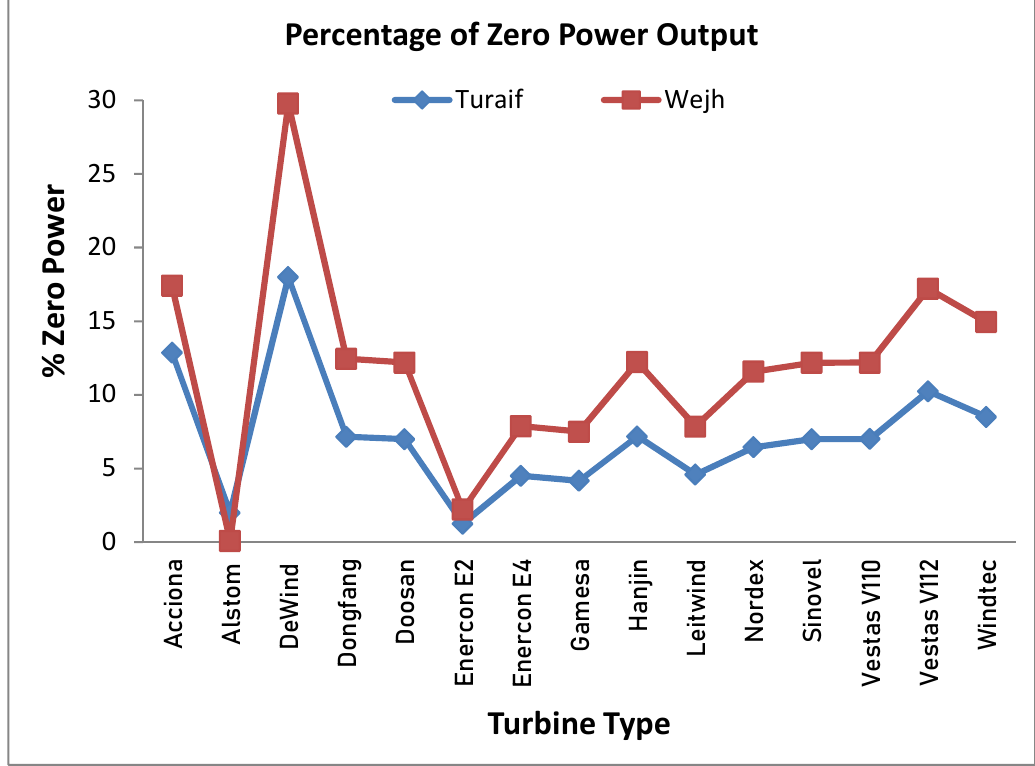
Figure 4. Comparison of ZPO for different turbines for Turaif and